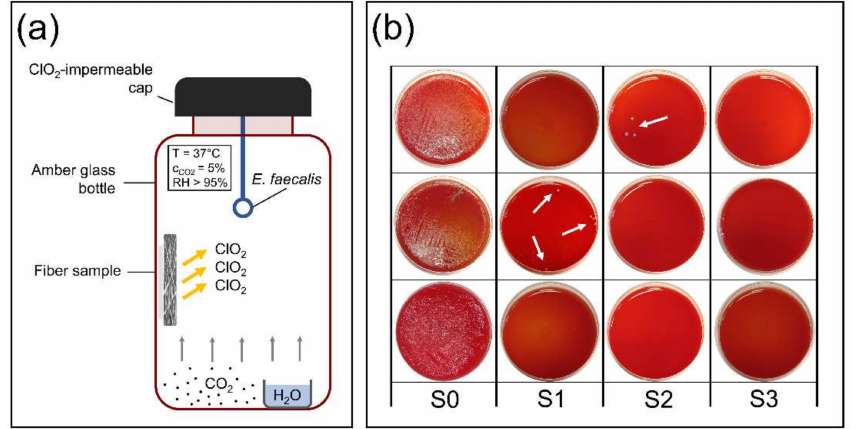
Figure 6. Experimental setup for bacterial inactivation study ( a ) and surviving colonies after incuba- tion and counting ( b ) (S0: unloaded PEO fibers—control, S1: 1 mg NaClO 2 -loaded PEO, S2: 5 mg